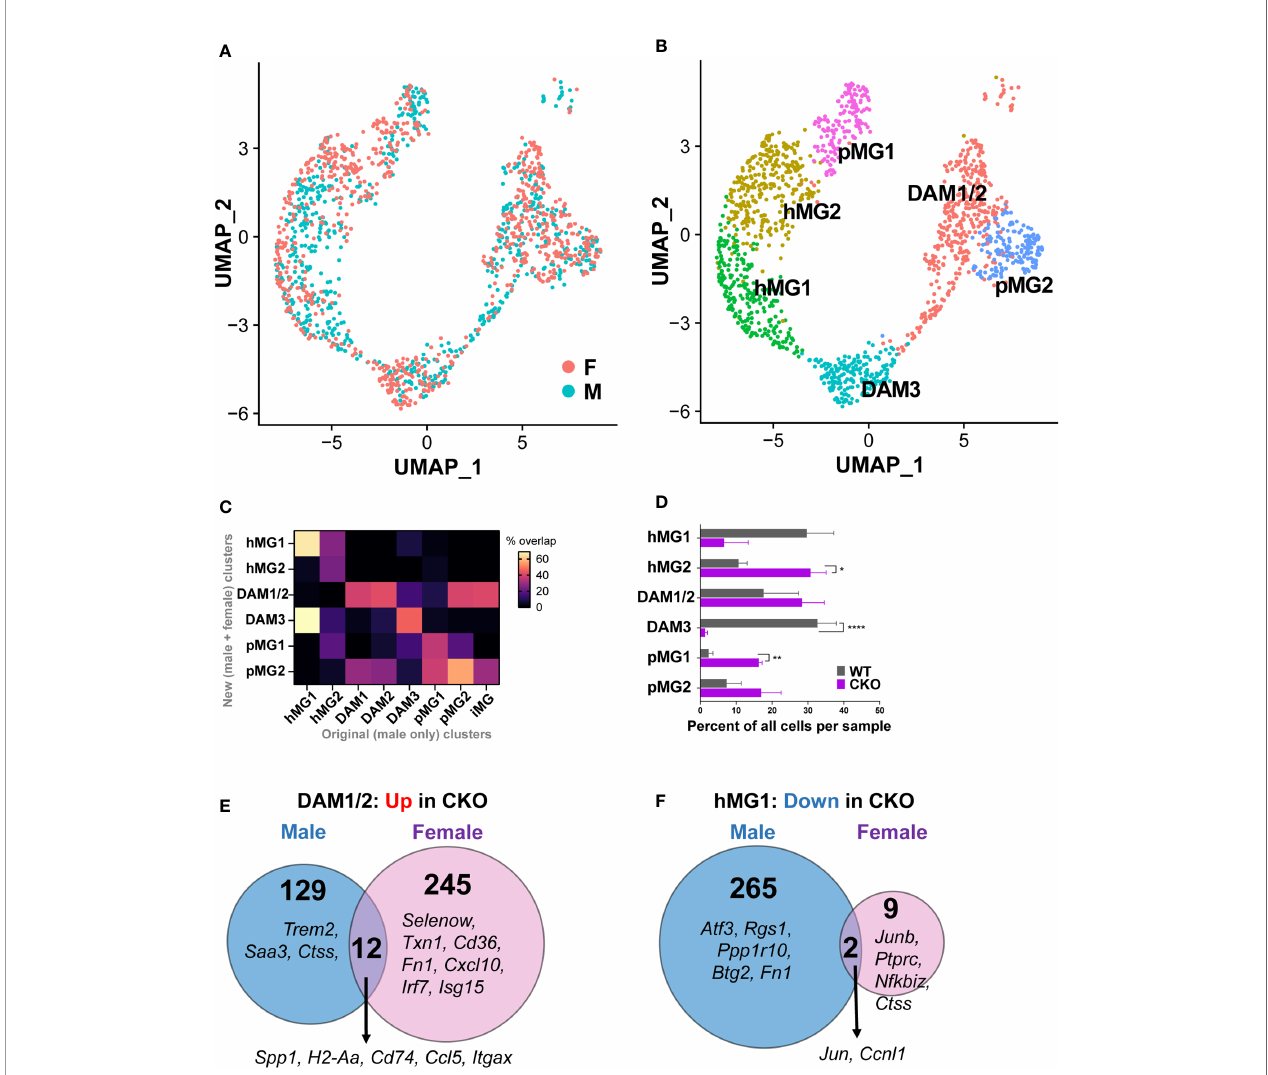
FIGURE 8 | Unique and overlapping roles of p38 a in female vs. male microglia. Microglia were isolated from female p38 a CKO Cx3cr1-ER (CKO; n=3) and WT control mice (n=3) during peak EAE and analyzed by scRNAseq as described in the Materials and Methods. scRNAseq data from male CKO (n=3) and WT microglia (n=3) ( - ) were integrated and reanalyzed together with the female data using Seurat v3. UMAP-based two-dimensional projection of single cells, shown by sex (A) or by cluster identity (B) . (C) Comparison of cluster identities originally de fi ned in for male microglia (X axis), with newly de fi ned clusters of male and female microglia (Y axis). The heatmap indicates percent overlap between the cluster marker genes for each cluster from each analysis, normalized to the maximum possible percent overlap given the size of each gene set. (D) The distribution of female WT and CKO cells across each cell cluster, expressed as the relative percent of each cell cluster, determined by dividing the number of cells in a given cluster by the total number of cells in a biological replicate. Signi fi cance of differences between WT and CKO are indicated as follows: *P < 0.05; **P < 0.01; ****P < 0.0001. (E) Comparison of DEGs upregulated (P<0.05, log2FC>0.2) in p38 a CKO relative to WT in male vs. females, in microglial cluster DAM1/2. (F) Comparison of DEGs downregulated (P<0.05, log2FC < -0.2) in p38 a CKO relative to WT in male vs. females, in microglial cluster